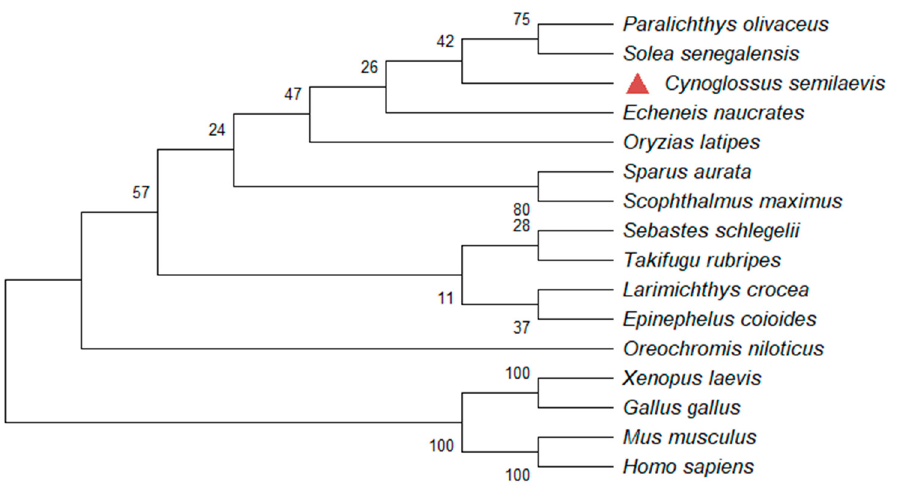
Figure 3. Phylogenetic relationships of C. semilaevis eEF1A1 from other representative species. The Neighbor-Joining tree was constructed by MEGA-11 1000 bootstrap replicates based on the full-length amino acid sequences same as above. C. semilaevis eEF1A1 was highlighted with red triangle. The relative genetic distances were explained by the scale bar and the branch lengths.